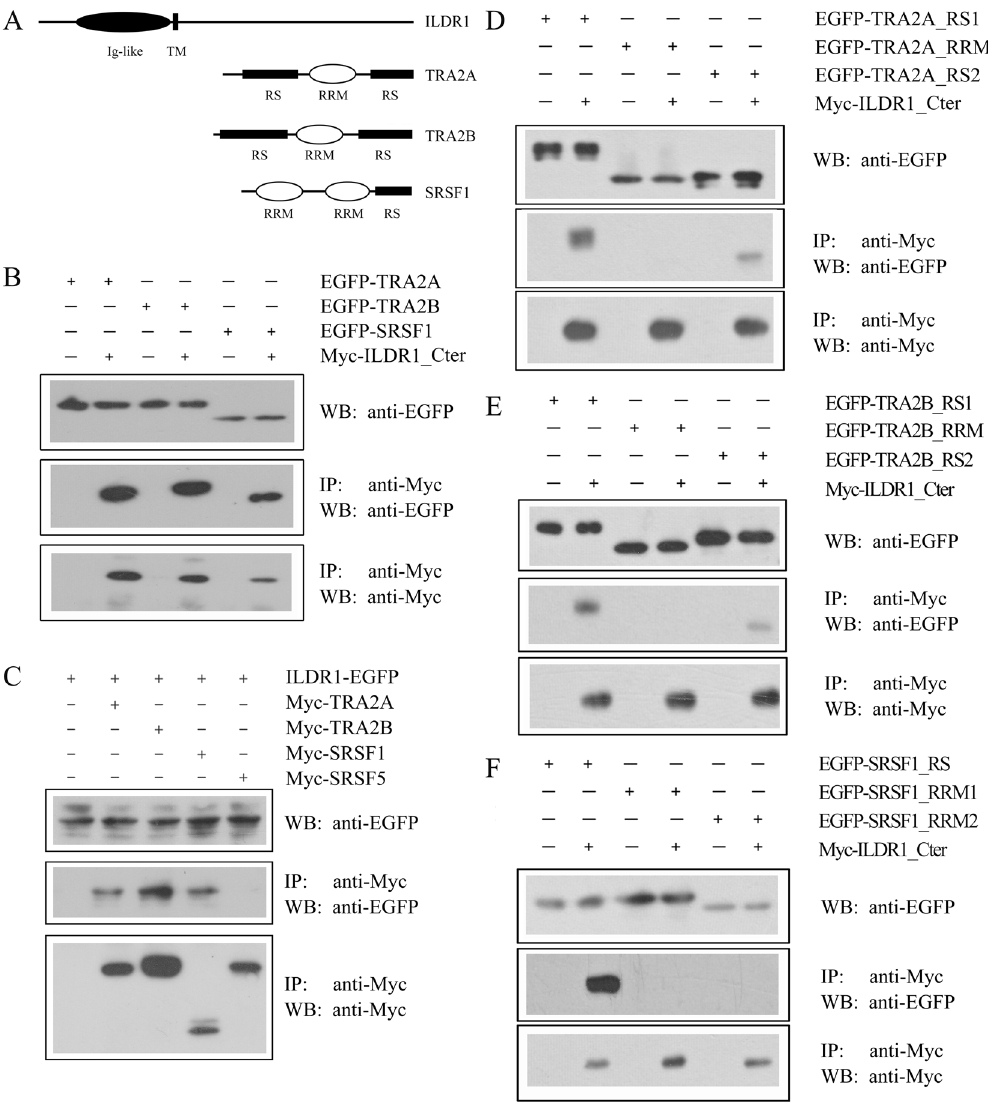
Figure 1. ILDR1 interacts with TRA2A, TRA2B, and SRSF1. ( A ) Schematic drawing of the domain structures of Mus musculus ILDR1, TRA2A, TRA2B, and SRSF1. ( B ) Western blots showing that EGFP-tagged TRA2A, TRA2B, and SRSF1 were co-immunoprecipitated with Myc-tagged ILDR1 cytoplasmic fragment. ( C ) Western blots showing that EGFP-tagged ILDR1 was co-immunoprecipitated with Myc-tagged TRA2A, TRA2B, SRSF1, but not SRSF5. ( D ) Western blots showing that EGFP-tagged TRA2A RS domain, but not RRM domain, was co-immunoprecipitated with Myc-tagged ILDR1 cytoplasmic fragment. ( E ) Western blots showing that EGFP-tagged TRA2B RS domain, but not RRM domain, was co-immunoprecipitated with Myc-tagged ILDR1 cytoplasmic fragment. ( F ) Western blots showing that EGFP-tagged SRSF1 RS domain, but not RRM domain, was co-immunoprecipitated with Myc-tagged ILDR1 cytoplasmic fragment. Expression vectors were transfected into HEK293T cells to express epitope-tagged proteins, and cell lysis were subject to immunoprecipitation. 5% of total protein was loaded as input. IP indicates antibody used for immunoprecipitation and WB indicates antibody used for detection. Uncropped blots are shown in Fig.